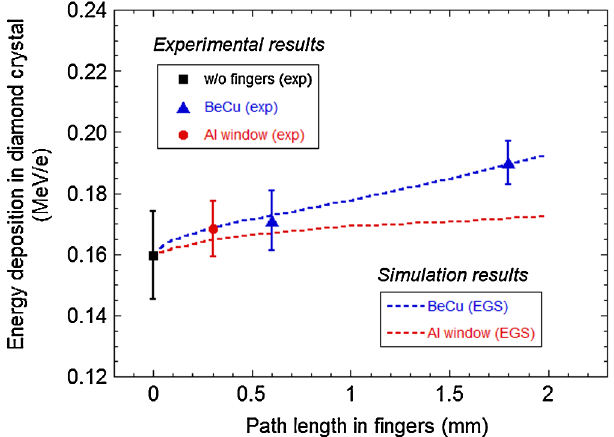
FIG. 7. Experimental and simulation results. The error bar for each experimental result indicates a measurement error of 1 standard deviation.